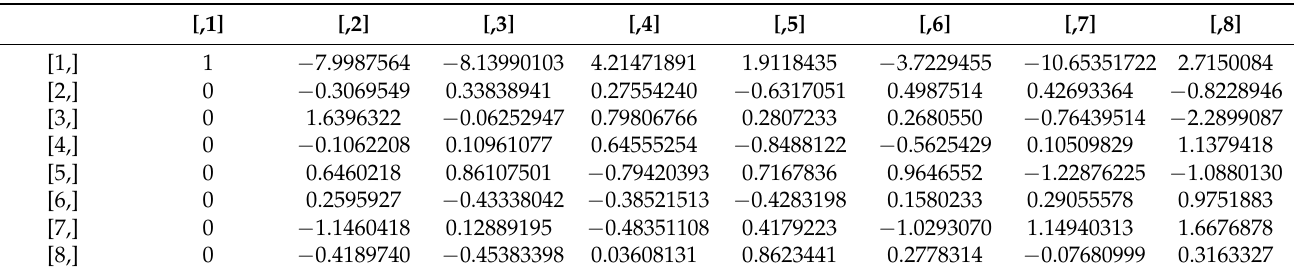
Table 5. Inverse matrix of D.